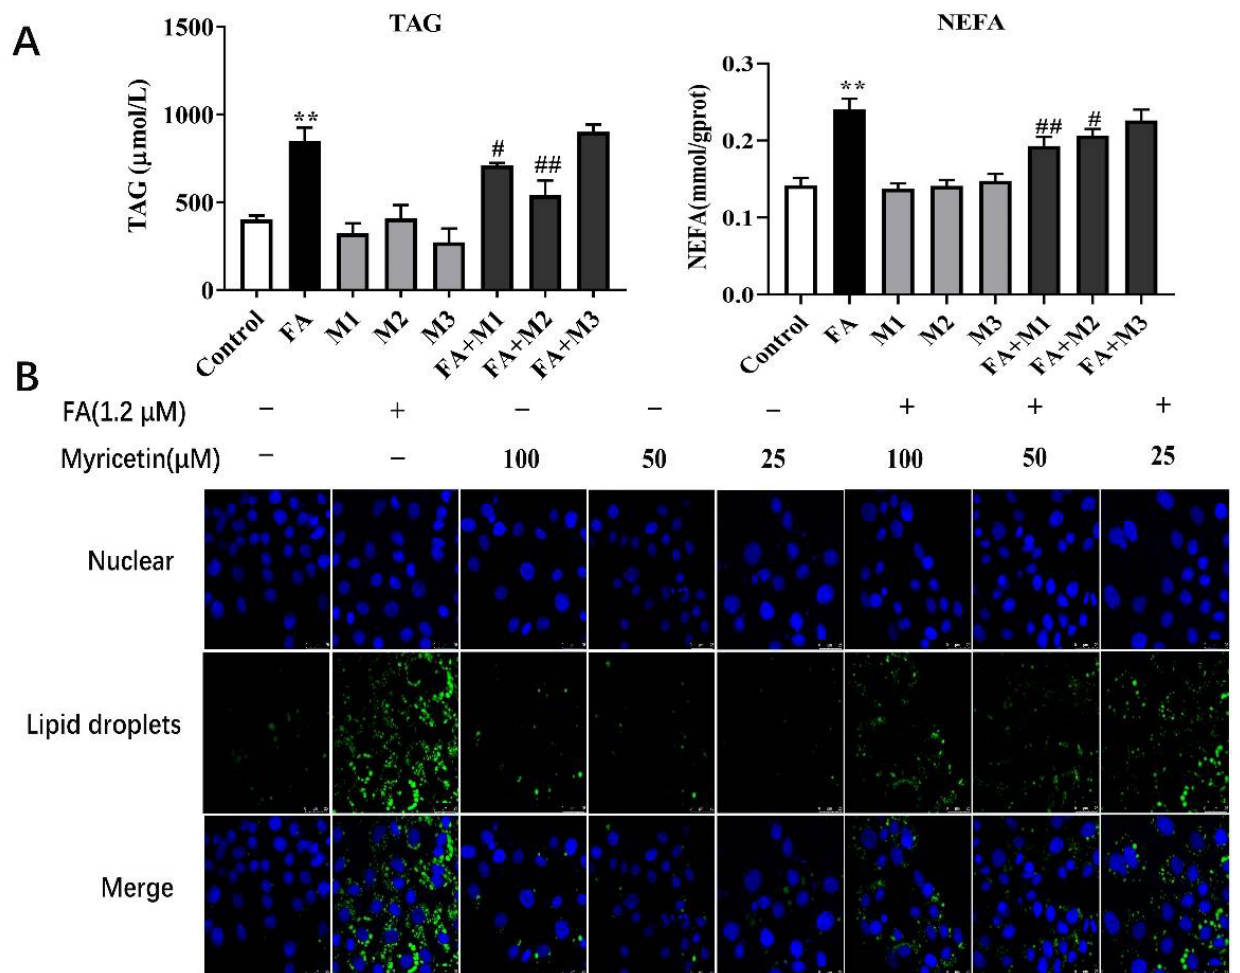
Figure 1. The effect of different concentrations of myricetin on TAG concentration and immunoflu- orescence of lipid droplets in primary calf hepatocytes. Hepatocytes were treated with 100 µ M (M1), 50 µ M (M2), 25 µ M (M3), or RPMI-1640 basic medium (Control) with or without 1.2 mM FA. ( A ) TAG content in hepatocytes. ( B ) Immunofluorescence results of lipid droplets, scale bar = 25 um. Data were analyzed using a two-way repeated-measure (RM) ANOVA with subsequent Bonferroni correction. The data presented are the means ± SEM; ** p < 0.01 indicate differences from the control. # p < 0.05, ## p < 0.01 indicate differences from cells incubated with FA. Compared with the FA group, the FA + M1 treatment group had a lower mRNA and protein abundance of SREBF1 ( p < 0.05 and p < 0.01, respectively) and DGAT1 ( p < 0.01), and a lower mRNA abundance of ACC1 and FASN ( p < 0.01; Figure 2B). However, the mRNA ( p < 0.05) and protein ( p < 0.01) abundance of CPT1A in the FA + M1 treatment group were greater compared with the FA (Figure 2B). The FA + M2 treatment group had a lower mRNA and protein abundance of SREBF1 ( p < 0.05 and p < 0.01, respectively) and DGAT1 ( p < 0.01), and a lower mRNA abundance of DGAT2 ( p < 0.05), ACC1 ( p < 0.05), and FASN ( p < 0.01; Figure 2B). The mRNA and protein abundance of CPT1A in the FA + M2 treatment group were greater compared with the FA ( p < 0.01; Figure 2B). However, the FA + M3 treatment group only led to lower mRNA and protein abundance of SREBF1 and